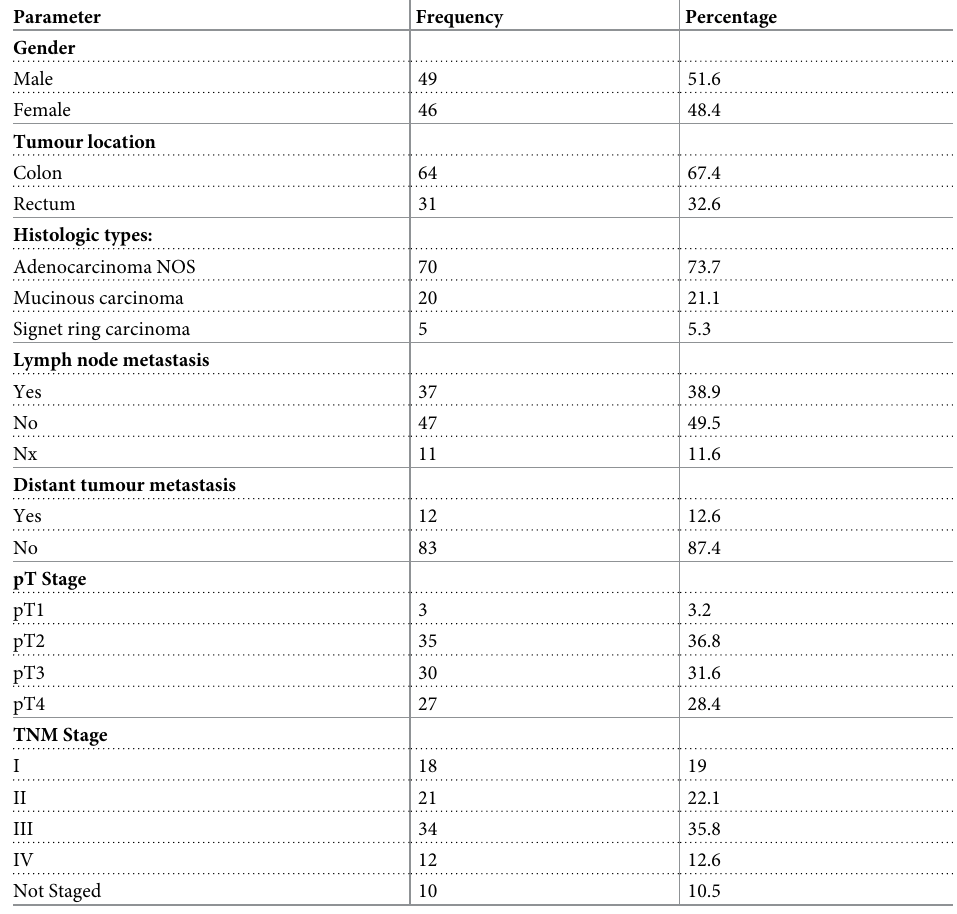
Table 1. Clinicopathological parameters of the patients and tumour